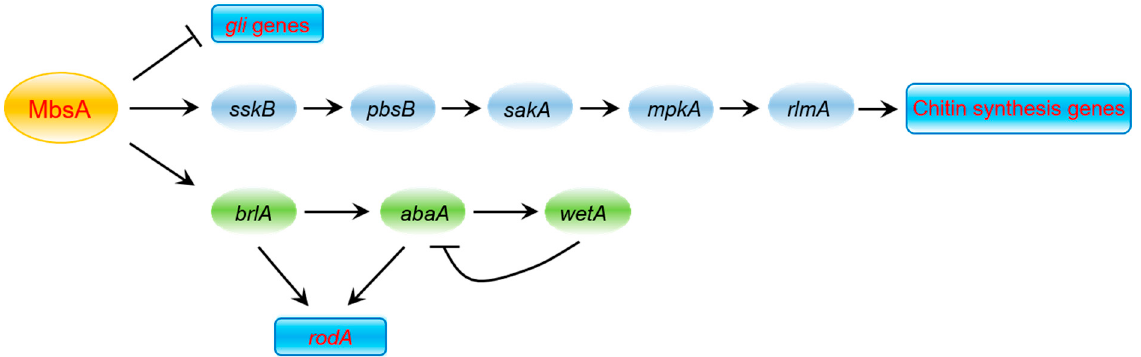
Figure 9. A genetic model depicting the role of MbsA in A . fumigatus . MbsA positively regulates asexual sporulation, rodA expression, the SakA MAP kinase pathway, and virulence, but negatively controls expression of gliotoxin-related genes and GT production.